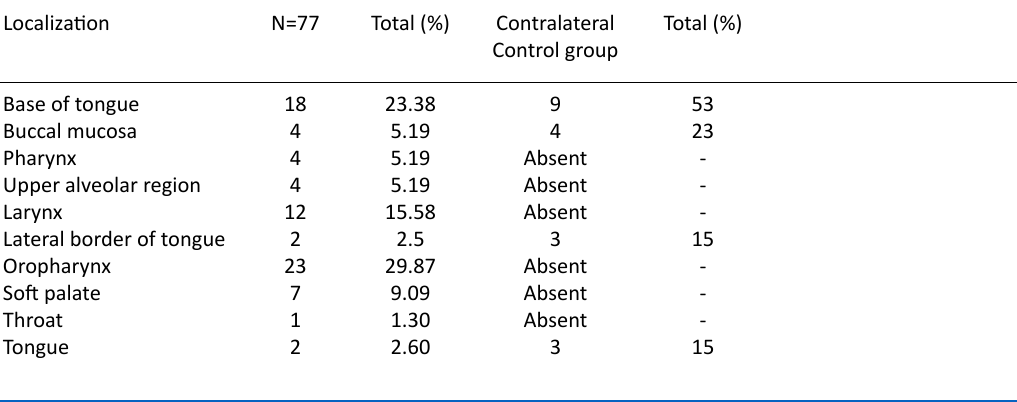
Base of tongue Buccal mucosa